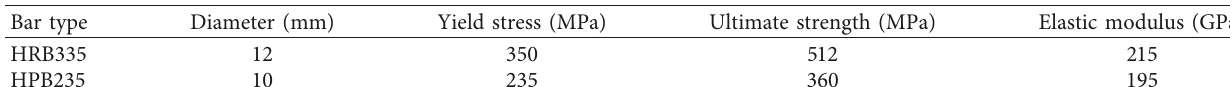
Table 2: Mechanical properties of the steel bars used in the present study.